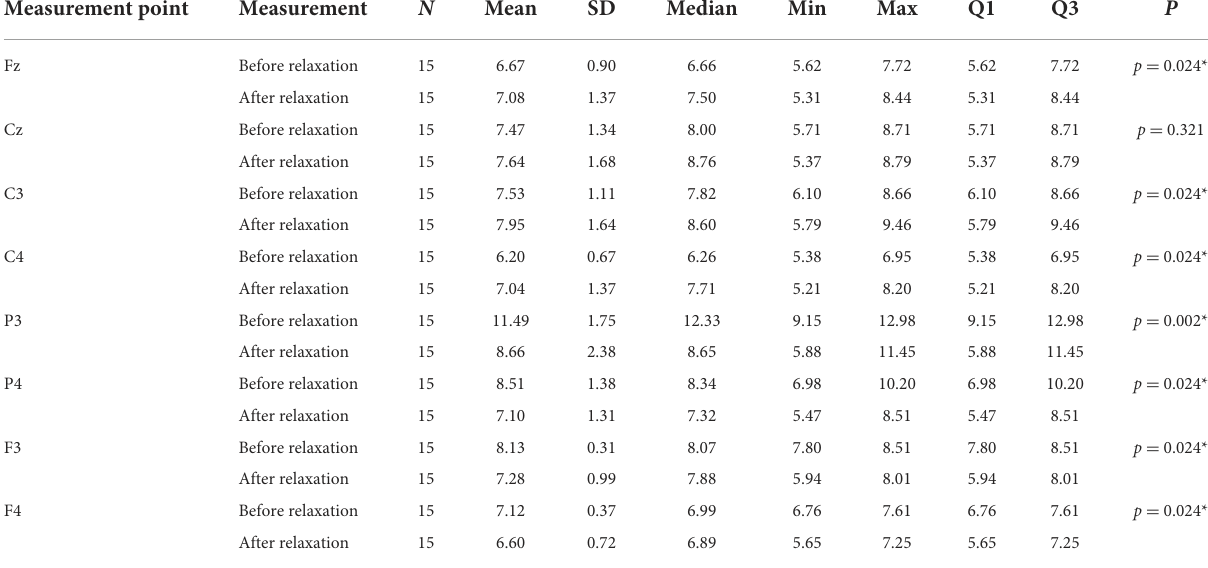
TABLE 6 Comparison of Beta 2 wave amplitudes before the SKY course (first day) and after the whole SKY course (third day) with eyes closed. Measurement